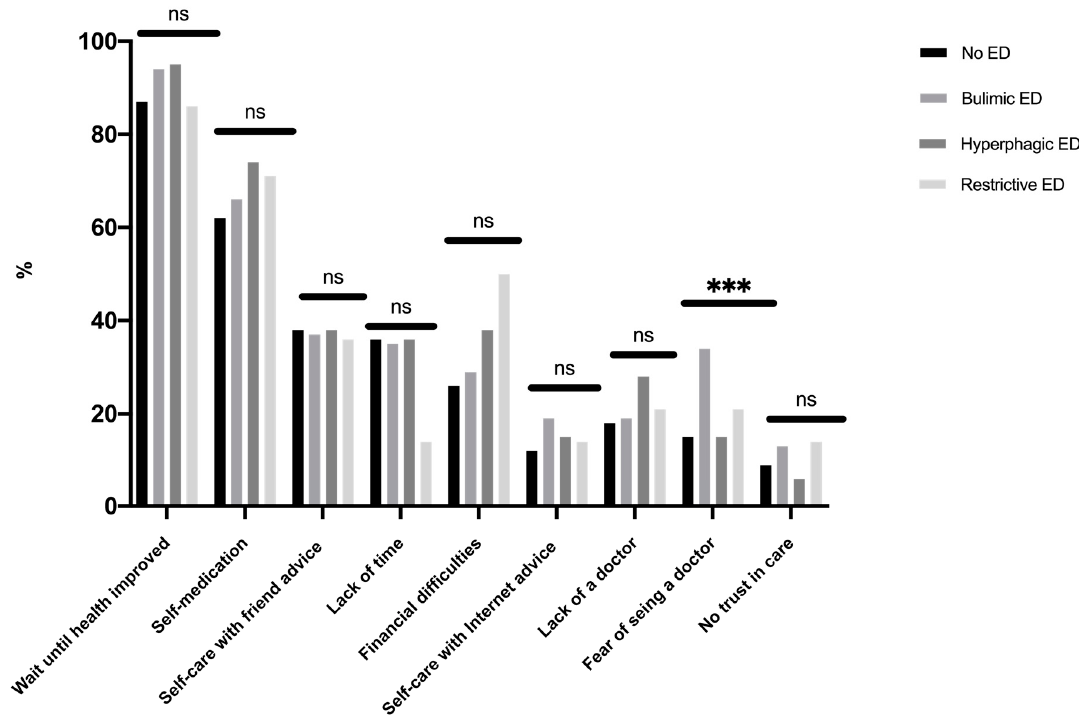
Figure 5. Reasons for foregoing seeing a general practitioner ( n = 325). ns: non significant. ***: p < 0.001.